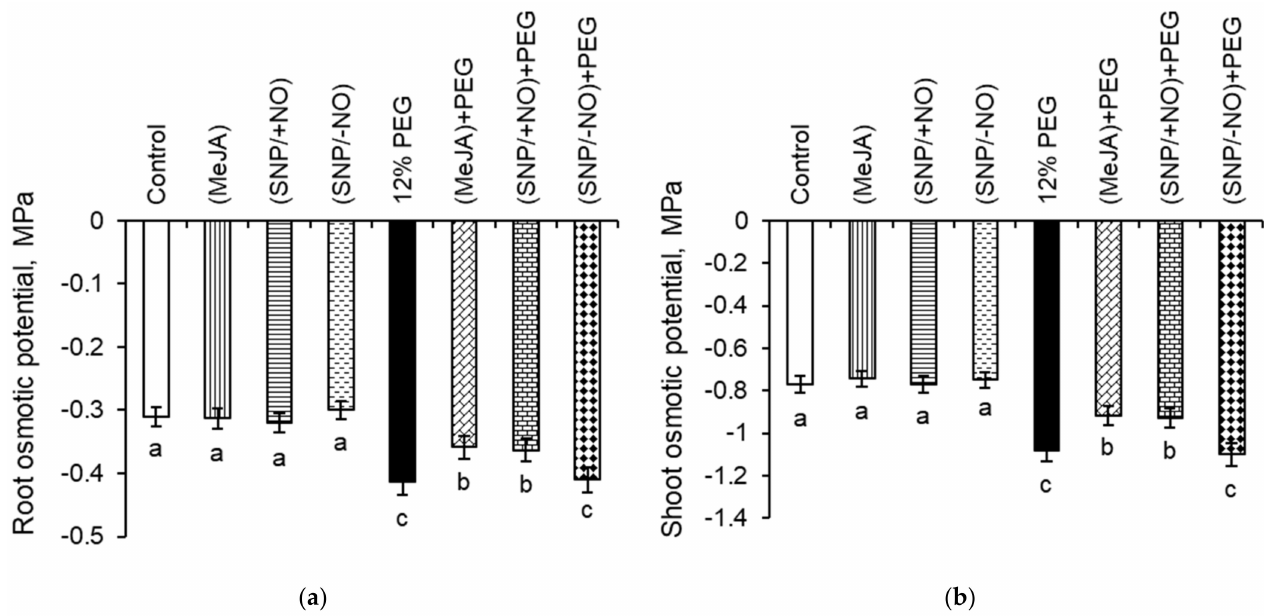
Figure 5. Effects of exogenous application of 10 − 7 M MeJA and 2 × 10 − 4 M SNP on osmotic potential of ( a ) roots and shoots ( b ) of wheat plant sap under drought stress, modulated by 12% PEG. Data are the mean of three replicates; different letters show significant difference at p ≤ 0.05 and bars indicate ± SE (n =